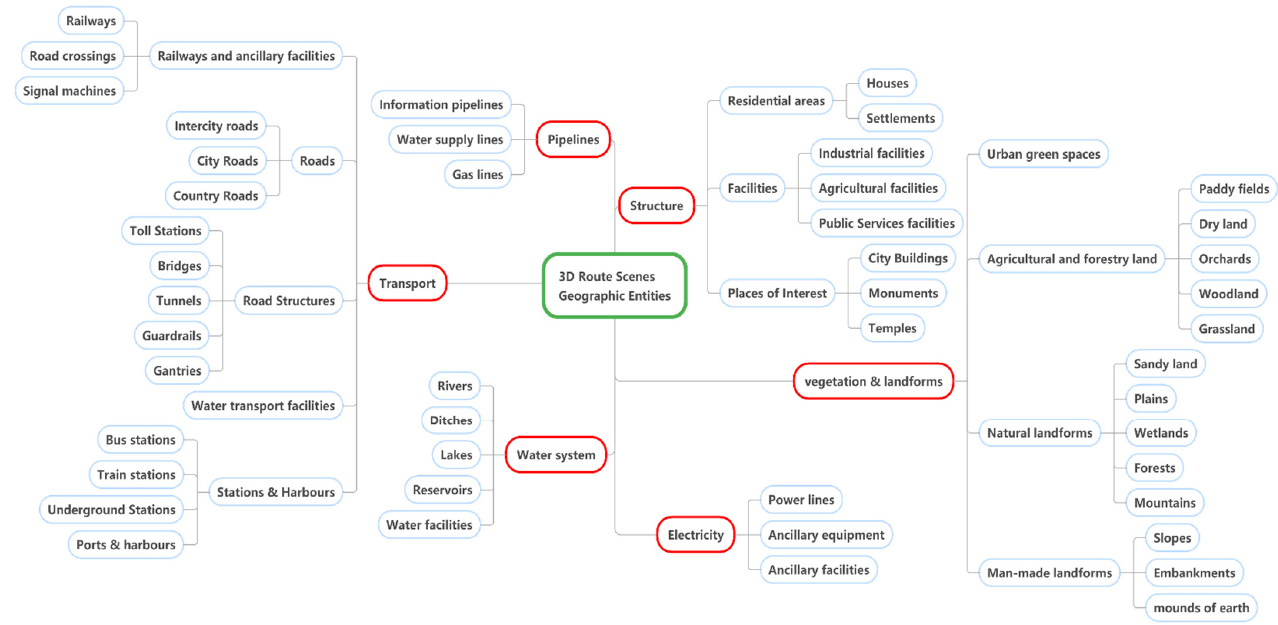
Figure 4. Natural classification of geographic entities for 3D route scenes. It has combined specific route scenes in reality according to relevant specifications. A classification of the geographical entities that may appear in the construction of 3D route scenes was made.